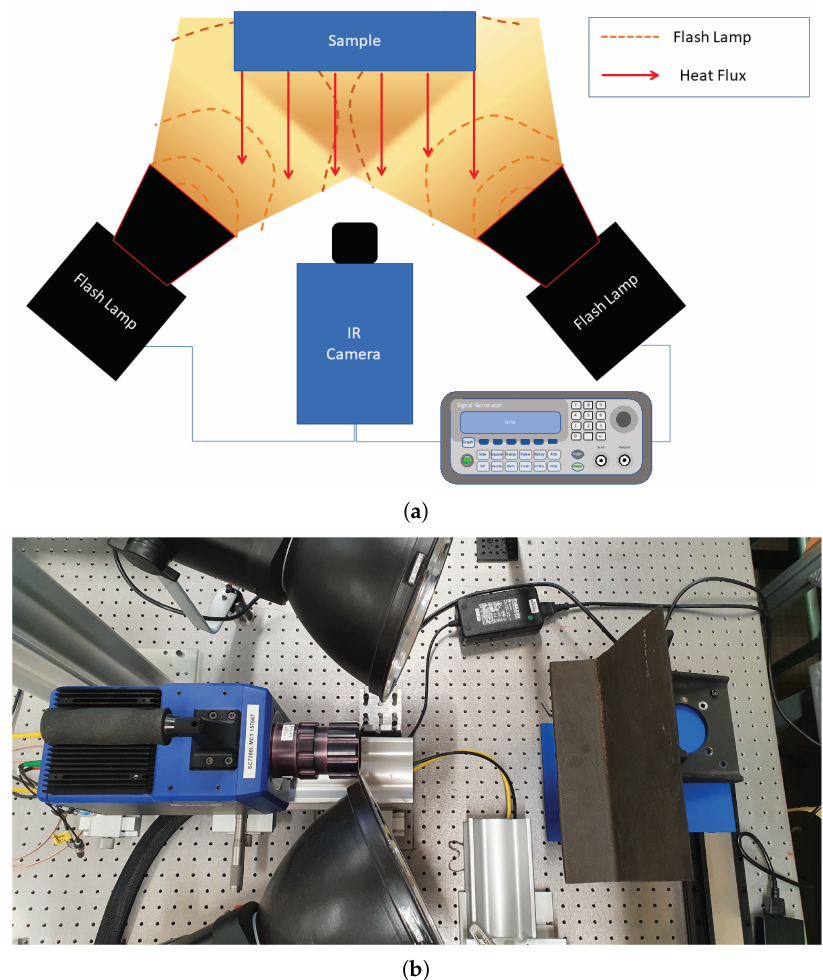
3Methods Figure 1. ( a ) Schema of the experimental setup and ( b ) photograph of the bench.